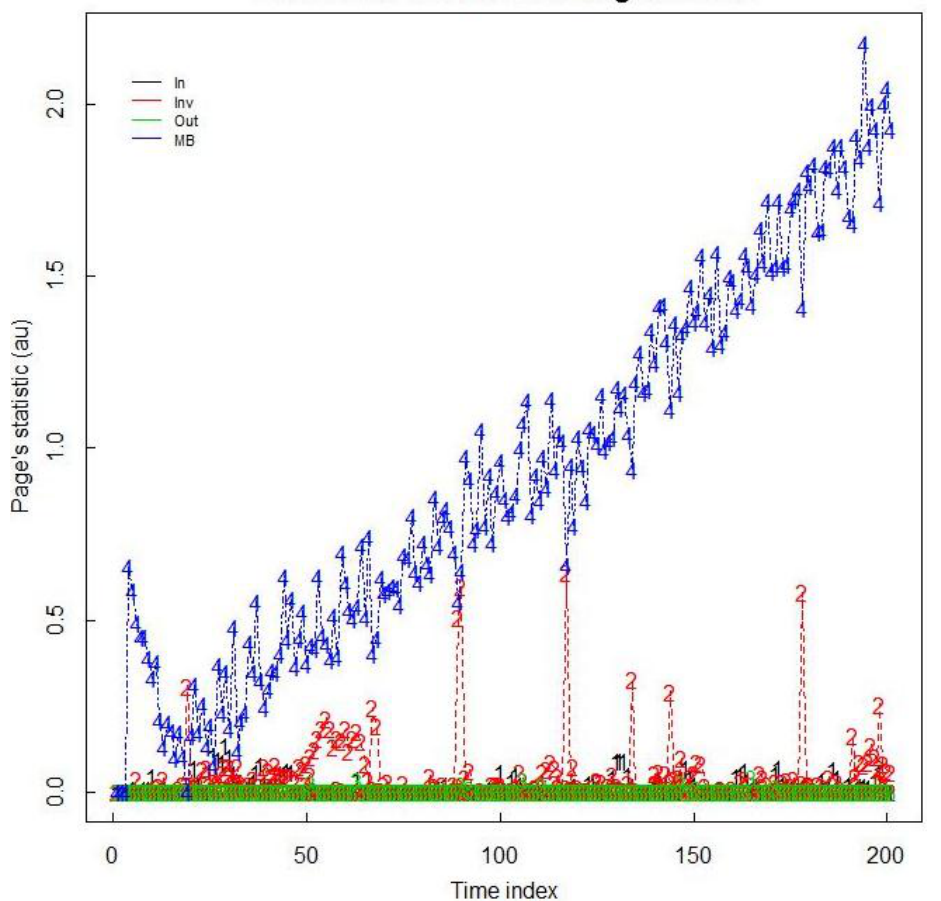
Figure 9. Page’s cusum test applied to each of the 14 (13 PM, one NMA) residual